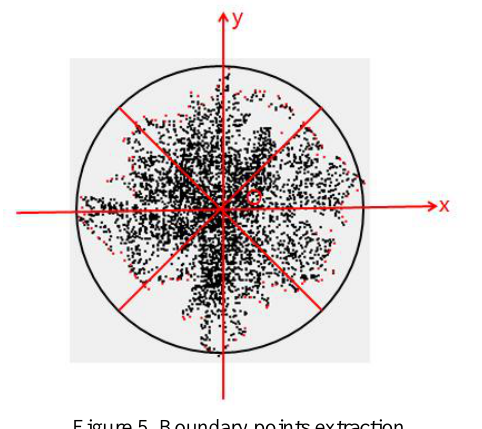
Figure 5. Boundary points